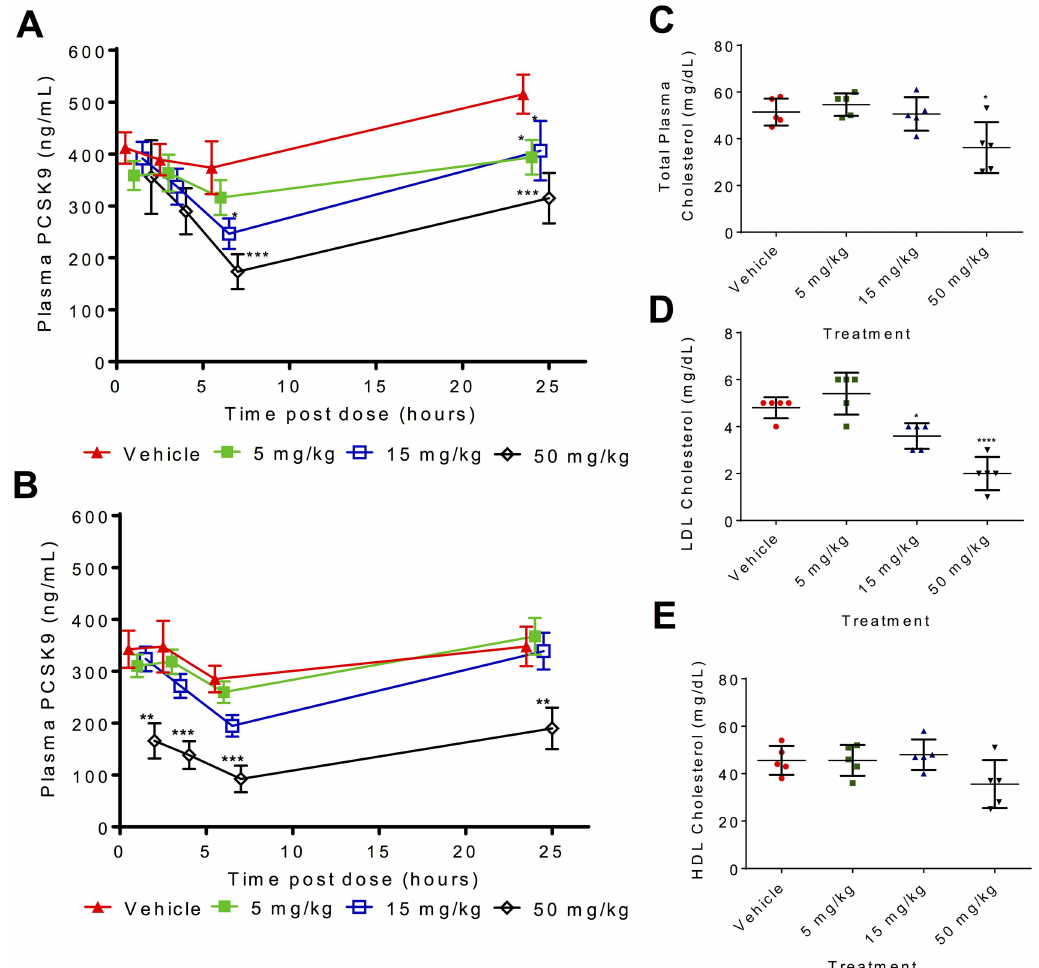
Fig 2. Oral administration of PF-06446846 reduces plasma proprotein convertase subtilisin/kexin type 9 (PCSK9) and total cholesterol levels in rats. (A–B) Plasma PCSK9 levels following(A) a single and (B) 12 daily oral doses of PF-06446848. Rats were administered the indicateddose of PF-06446846, and plasma concentrations of PCSK9 were measuredby commercial ELISA at 1, 3, 6, and 24 h after dosing (A) or the 12th daily dose (B). Symbols representmean concentration ± standard error and were jittered to providea clearer graphicalrepresentation. Data were analyzedusing a mixed model repeatedmeasure(MMRM) with treatment, day, and hour as fixed factors; treatment by day and hour as an interaction term; and animalas a randomfactor. The significancelevel was set at a level of 5%. No adjustmentfor multiple comparisons was used. * p (cid:20) 0.05, ** p (cid:20) 0.01, *** p (cid:20) 0.001. (C–E) Total plasma (C), low-density lipoprotein(LDL) (D), and high-density lipoprotein(HDL) (E) cholesterollevels in rats measured 24 h following14 daily oral doses of PF-06446846. Symbols represent individualanimalvalues. The middle horizontal bar representsthe group mean ± standard deviation. Differencebetweengroup means relative to vehicle was performed by a one-wayANOVA followedby a Dunnett’smultiple comparisons test; * p (cid:20) 0.05, **** p (cid:20) 0.0001. The individual quantitative observations that underlieFig 2 are in S14